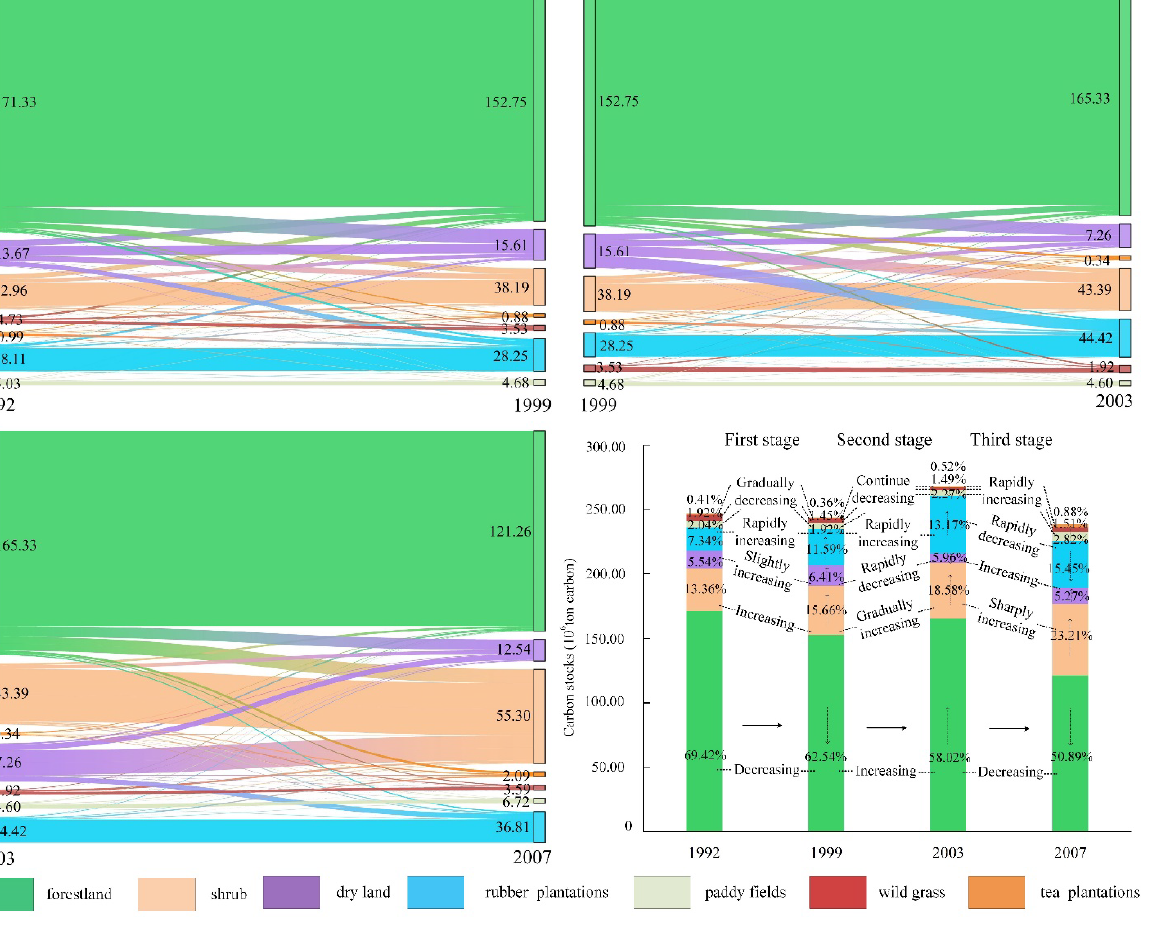
Figure 3. Changes in carbon stocks in Xishuangbanna.